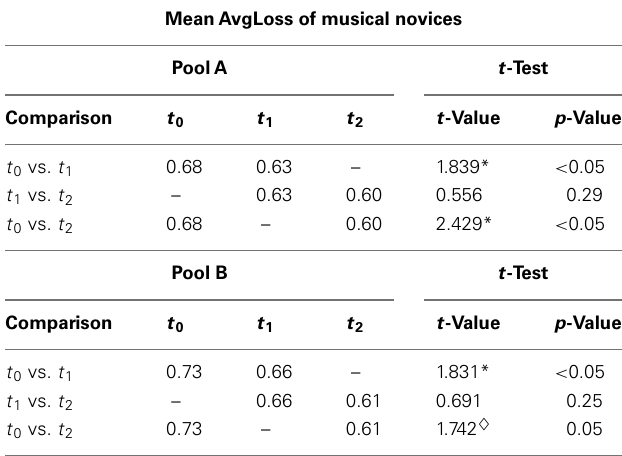
Table 1 | “Improvements ofAvgLoss in musical